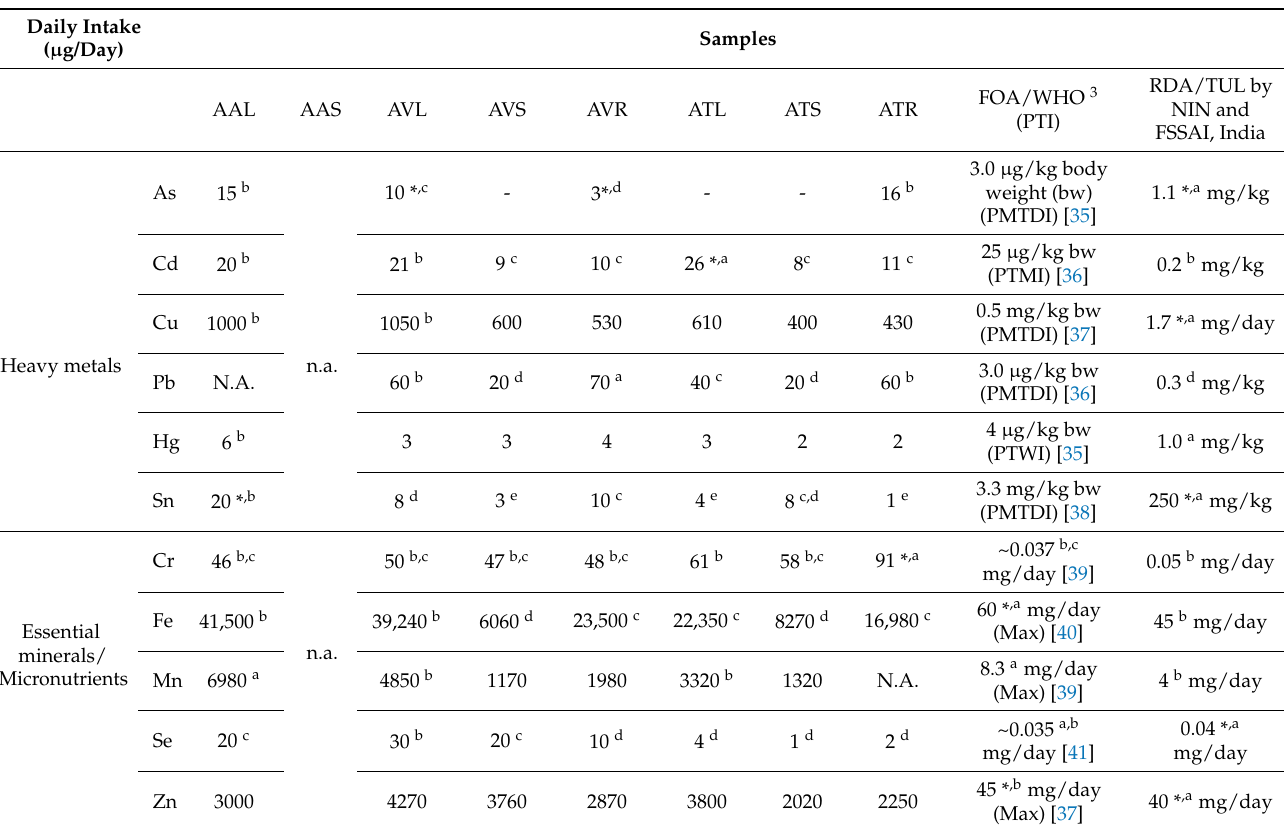
Table 2. Estimation 1 of daily intake of heavy metals and micronutrients by Indians (RDA for GLV consumption, 100 g/person 2